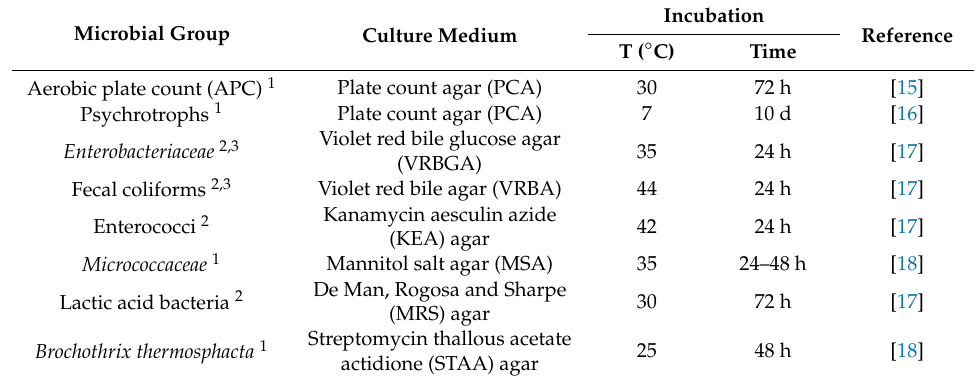
Table 1. Culture media, incubation times, temperatures and references used for microbiological analysis. Microbial